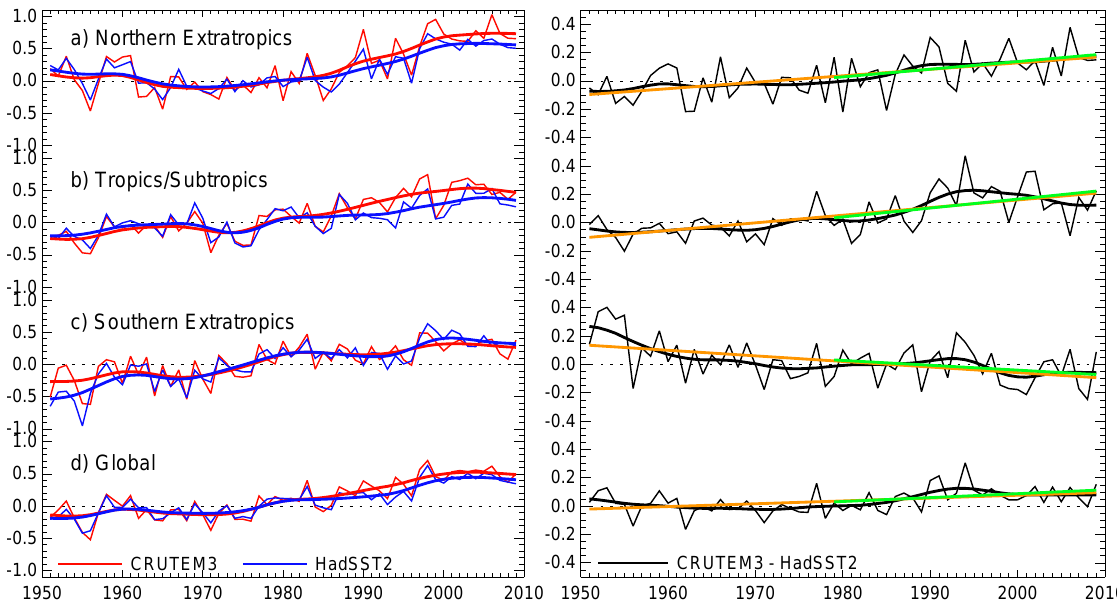
Figure 3. (a) ‘Northern Extratropics’, (b) ‘Tropics/Sub-Tropics’, (c) ‘Southern Extratropics’, and (d) ‘Global’ average of CRUTEM3 (red), HadSST2 (in blue) and the CRUTEM3–HadSST2 difference (in black) series. Low-frequency components (10-year Gaussian filters) are over-plotted, as well as trends for the CRUTEM3–HadSST2 difference, for 1951–2009 (orange lines) and 1979–2009 (green lines). Note the different scale on the ordinate axis of the right-column set of